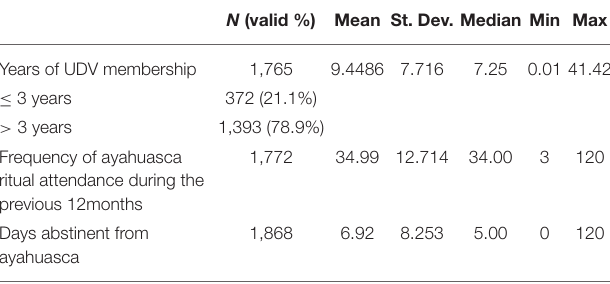
TABLE 2 | Ayahuasca ritual attendance variables.